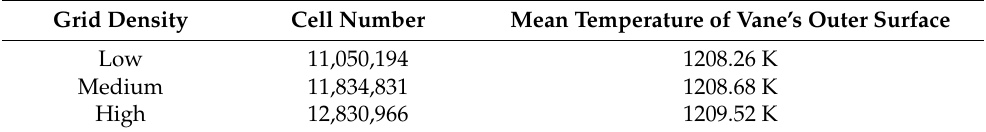
Table 2. Grid independence test.